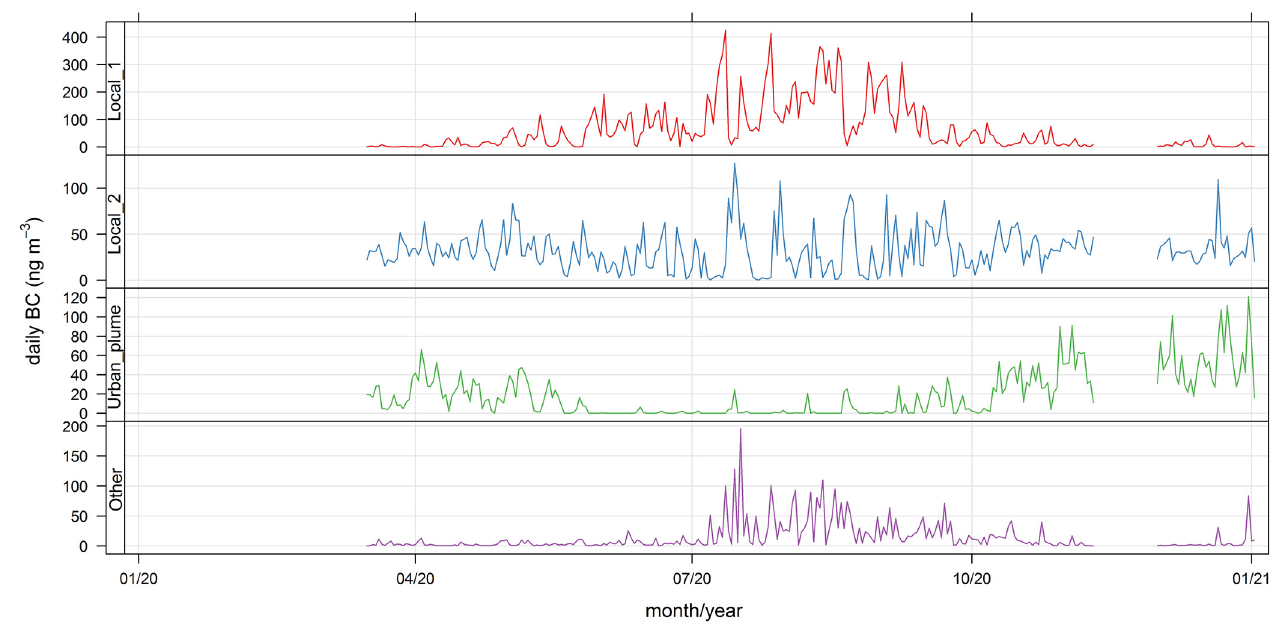
Figure 10. Time plot of daily source contributions to BC wb